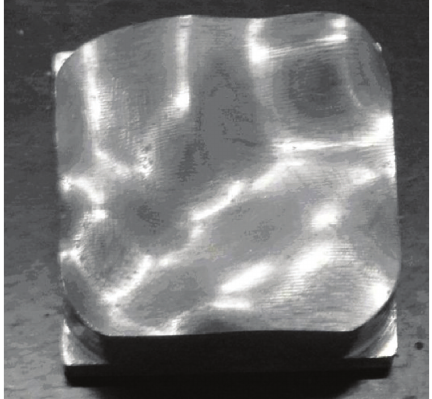
Figure 5: Point cloud by CMM adaptive